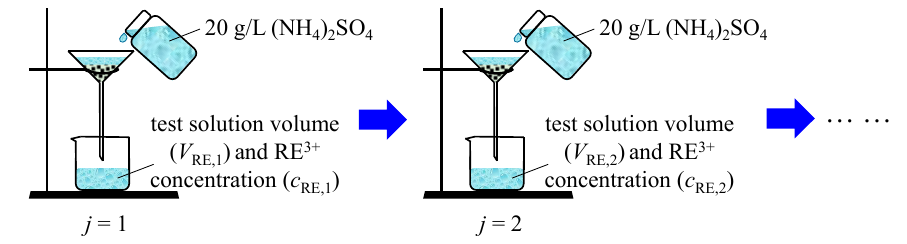
Figure 1. Schematic of the experiment.